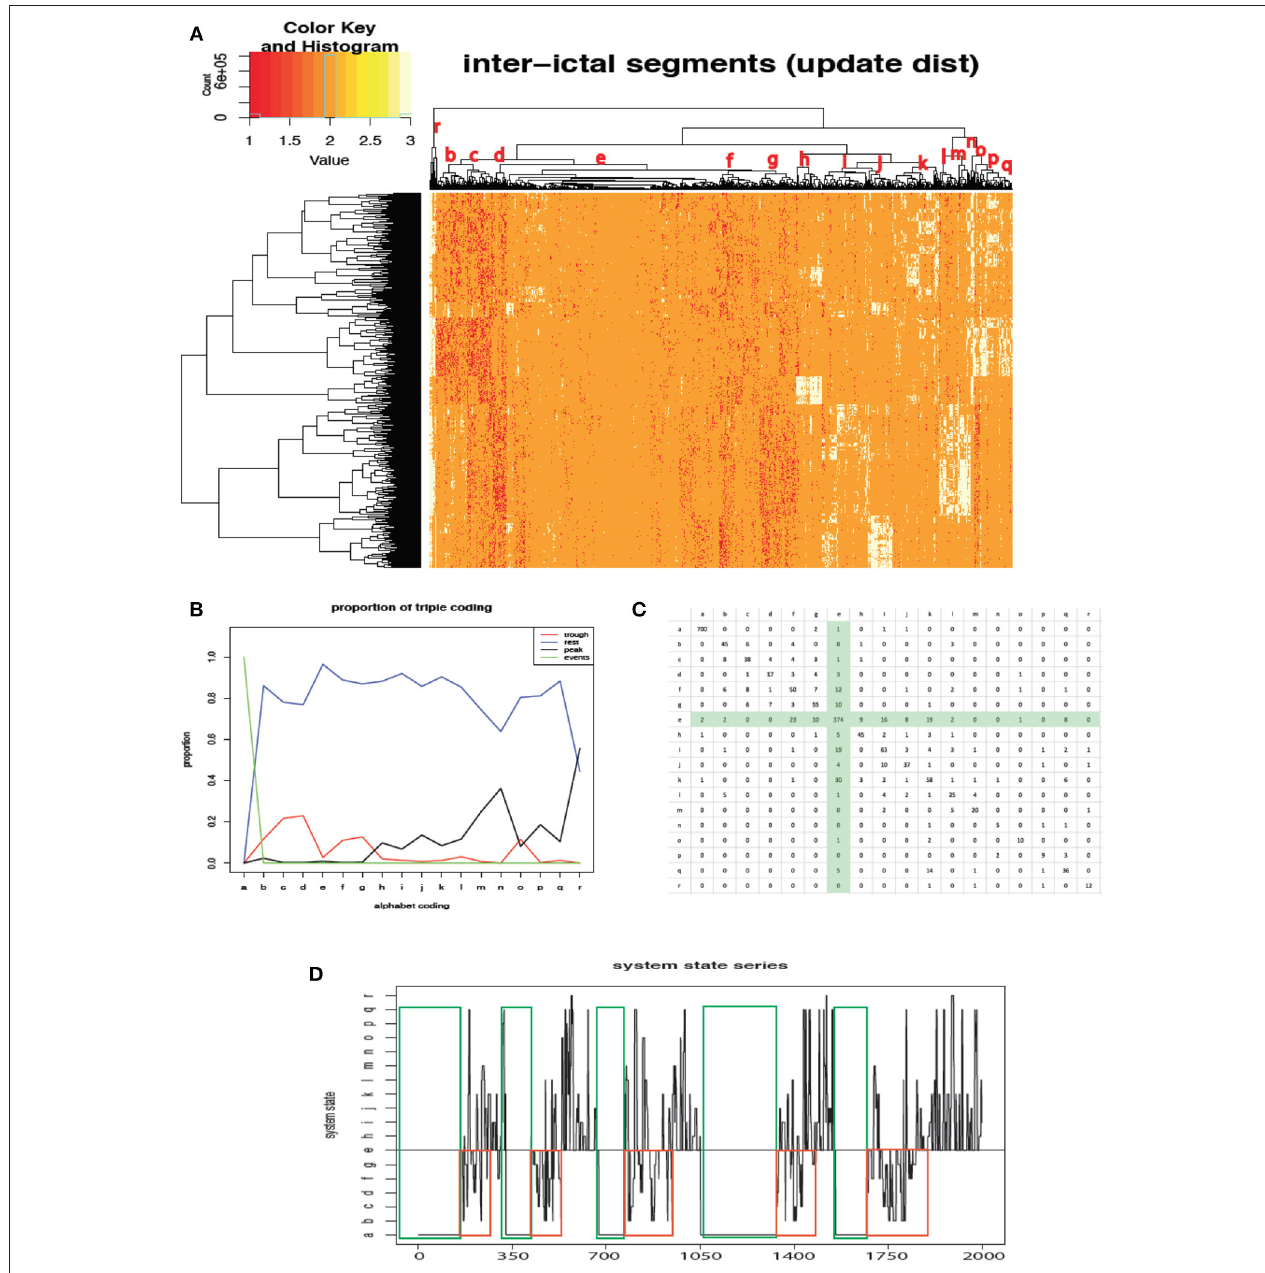
FIGURE 4 | System state identification and trajectory: (A) identification of system states resulted from Data Mechanics computations; (B) functional markers of system states; (C) transition probability matrix; (D) seizure-bearing patterns of system state trajectory across all five inter-ictal periods.